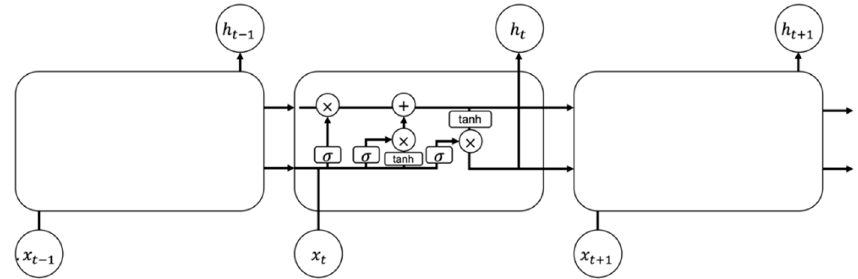
Figure 7. The structure of the LSTM model.